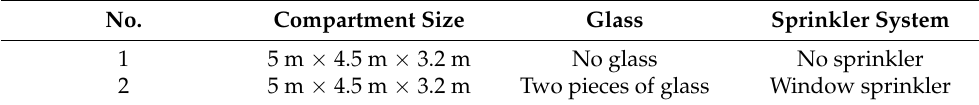
Figure 1. Schematic diagram of the experimental setup. Table 1. Experimental conditions.